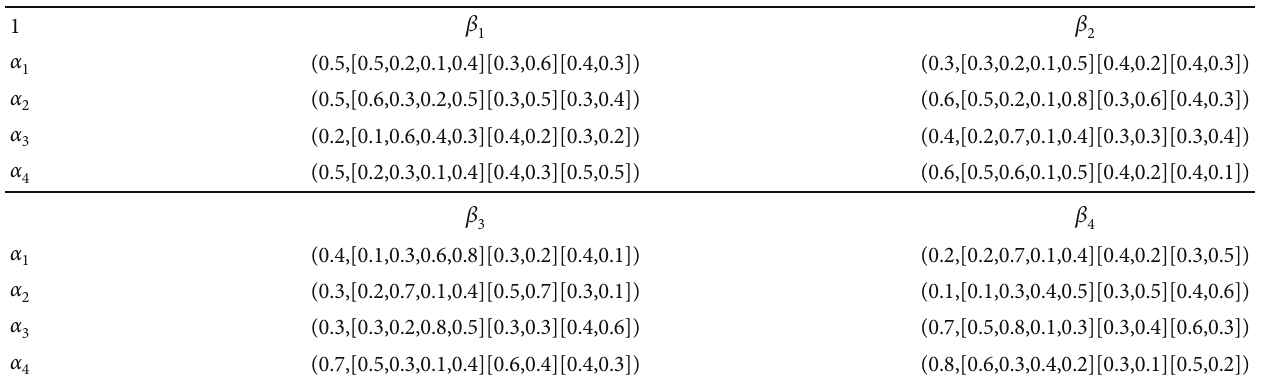
Table 1: Decision matrix of expert -1 (H 1 ).